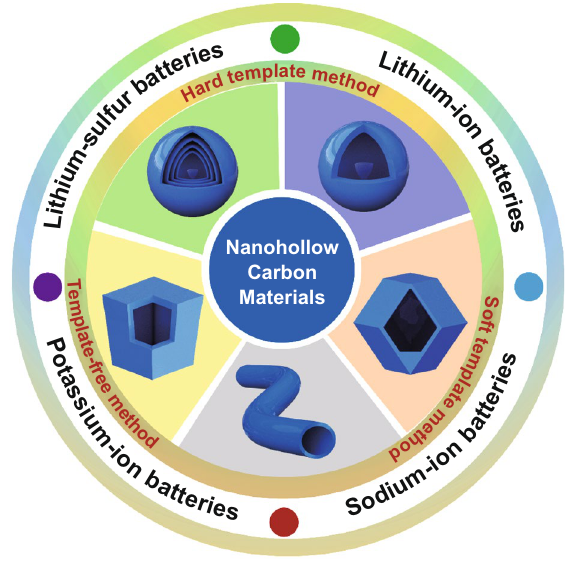
Fig. 2 Schematic illustrations of various morphologies for nanohol- low carbon materials used for rechargeable